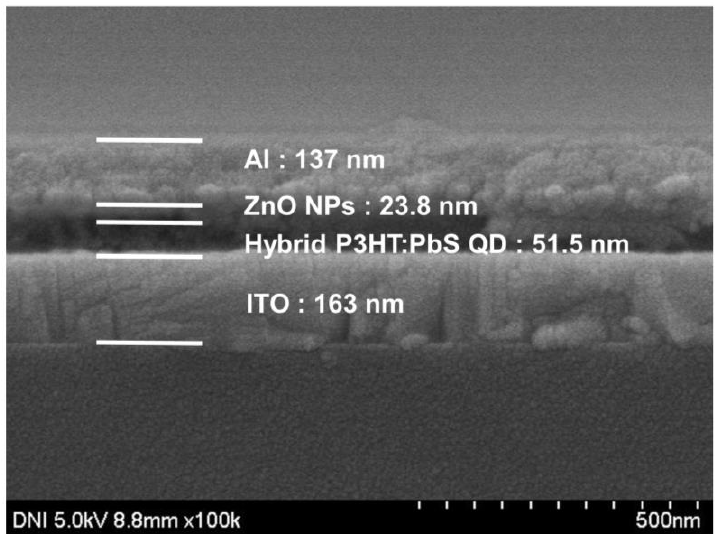
Figure 6. FE-SEM image of fabricated hybrid P3HT:PbS QD-based device.